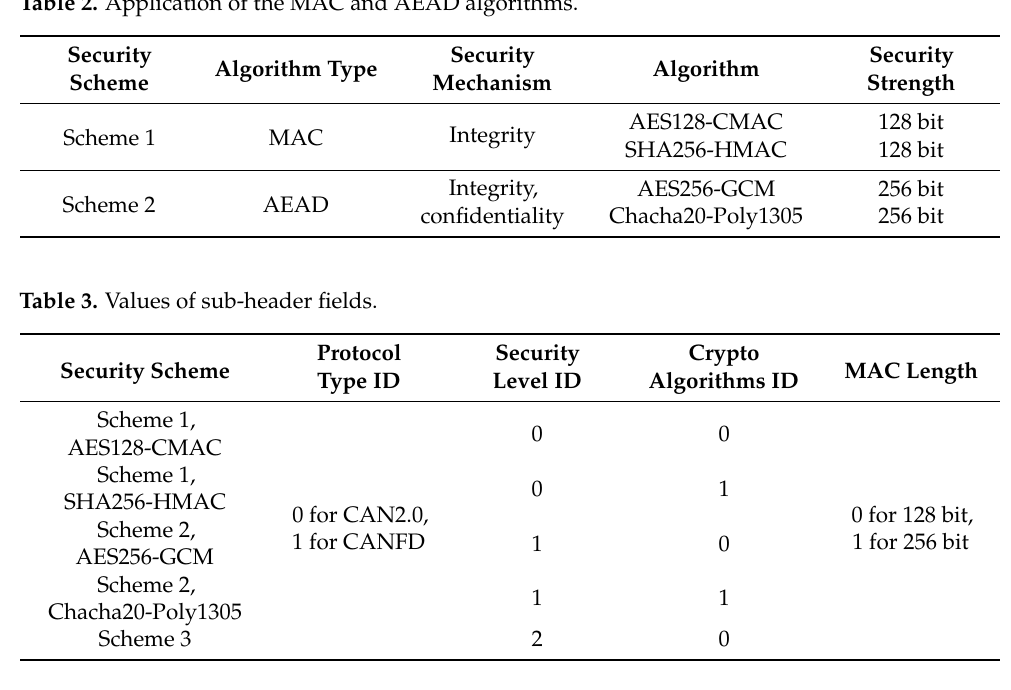
Table 2. Application of the MAC and AEAD algorithms.